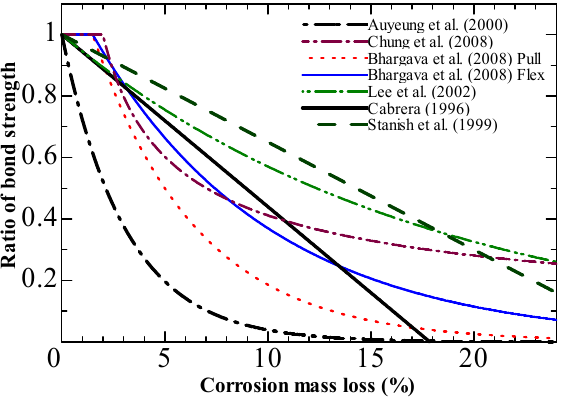
Figure 17. Comparisons of model predictions based on mass loss [4,42,67–70]. The same degradation trends are observed in almost all proposed empirical